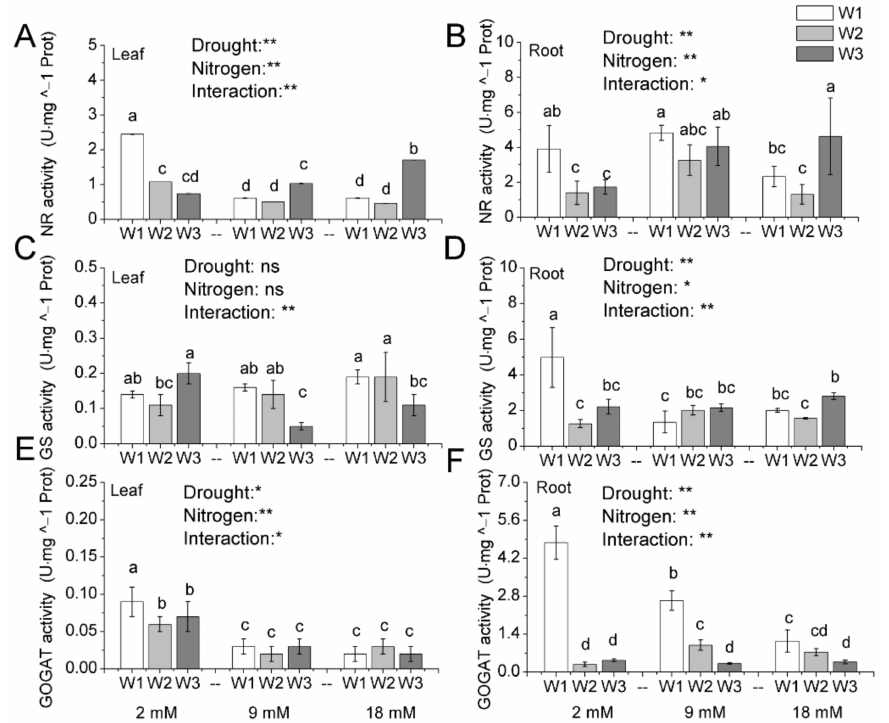
Figure 5. The activity of nitrate reductase ( A , B ), glutamine synthetase ( C , D ) and glutamate synthetase ( E , F ) in leaves and roots of pakchoi by different drought and nitrogen supply. W1: 0 g · L − 1 PEG 6000, blank; W2: 60 g · L − 1 PEG 6000, mild drought stress; W3: 120 g · L − 1 PEG 6000, moderate drought. Bars with the different letters indicate significant difference ( p < 0.05). Error bars represent the standard deviation. p -values of the ANOVAs of drought, nitrogen supply, and their interaction are indicated. ns, not significant. * p < 0.05. ** p <